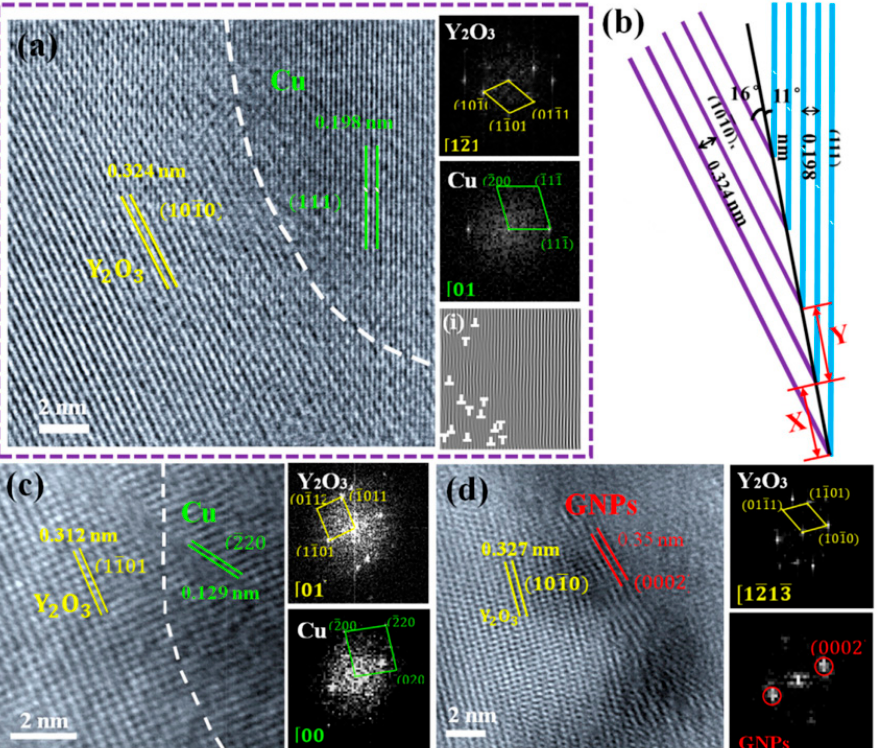
Figure 1. TEM and HRTEM images of existing form and dispersion of nanoparticles: ( a ) TEM of existing morphology of GNPs within the matrix; ( b ) Enlarged TEM images of ( a ); ( c ) HRTEM images of existing form of nanoparticles; ( d ) Schematic illustration of dispersion of nanoparticles [16]. Re- printed/adapted with permission from Ref. [16]. Copyright year 2020, Elsevier.